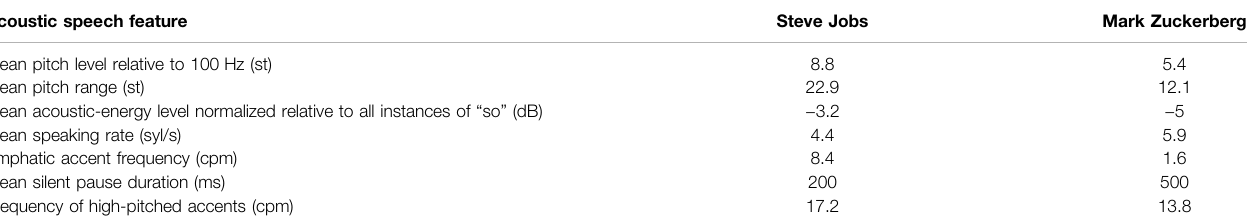
TABLE 1 | The acoustic features manipulated.